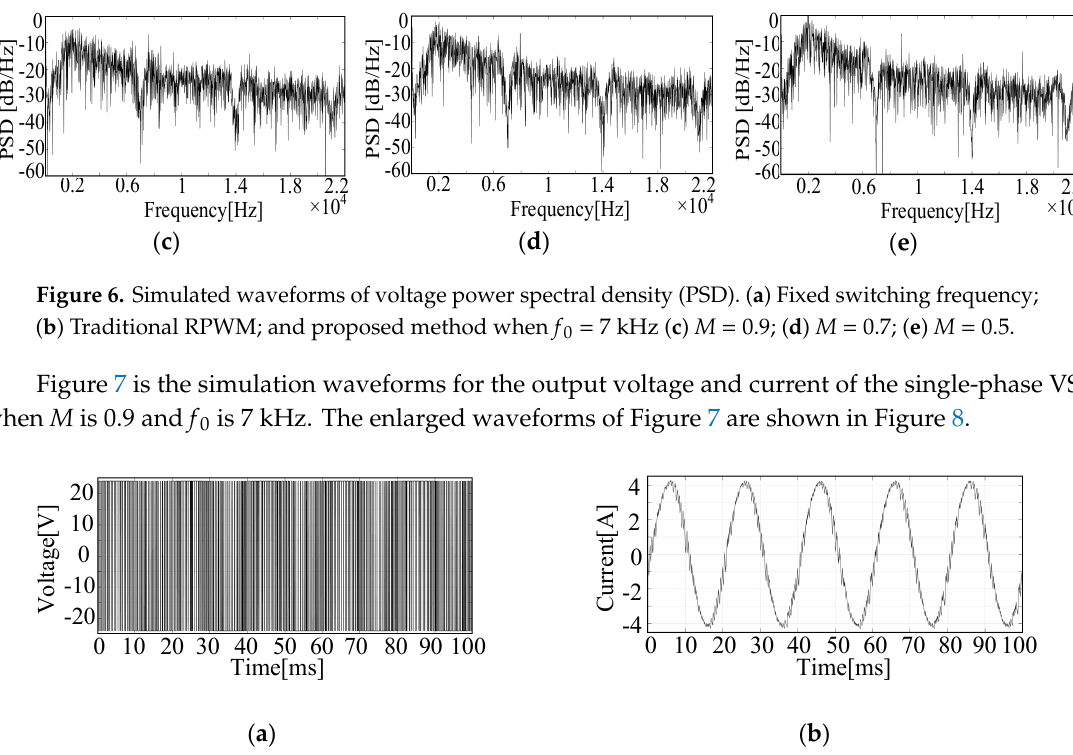
Figure 7. Simulated waveforms of single-phase inverter ( a ) voltage; ( b ) current.